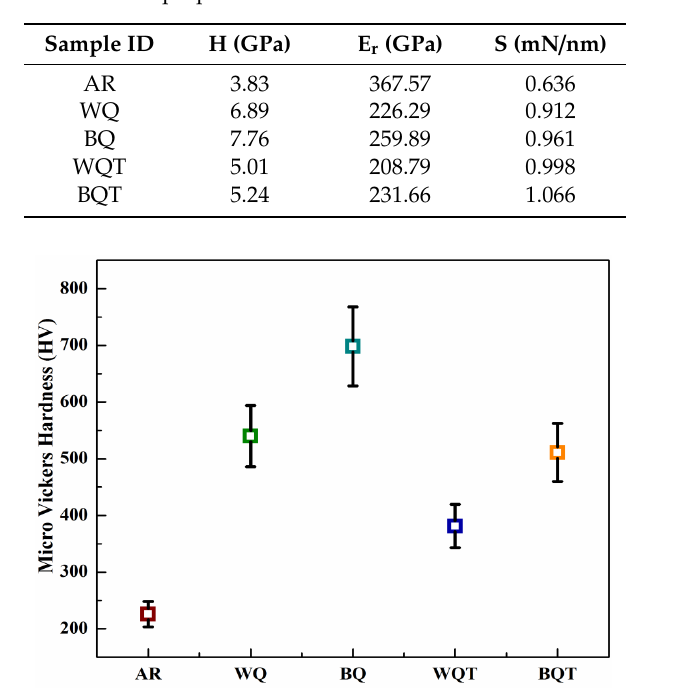
Figure 4. Micro Vickers hardness values of as-received and quench-hardened, tempered low-carbon steel.